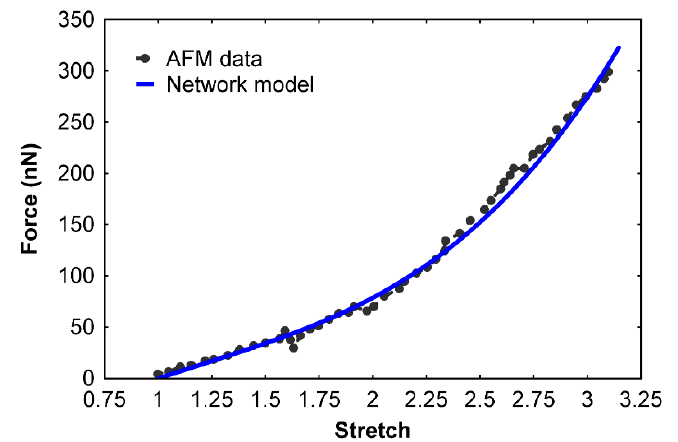
Figure 5. Fibrin fiber force–stretch relationship of our new multiscale network model (Model 2) compared with atomic force microscopy data [21]. The network model (Model 2) accounts for inter-protofibril binding forces.